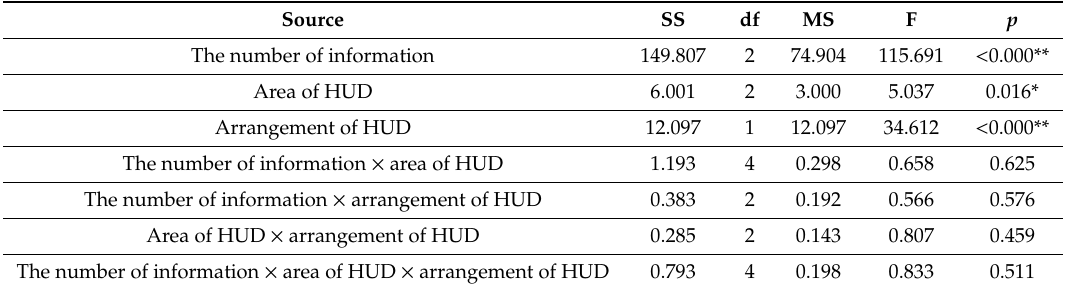
Table 3. Repeated measures (RM)-ANOVA results for response time.